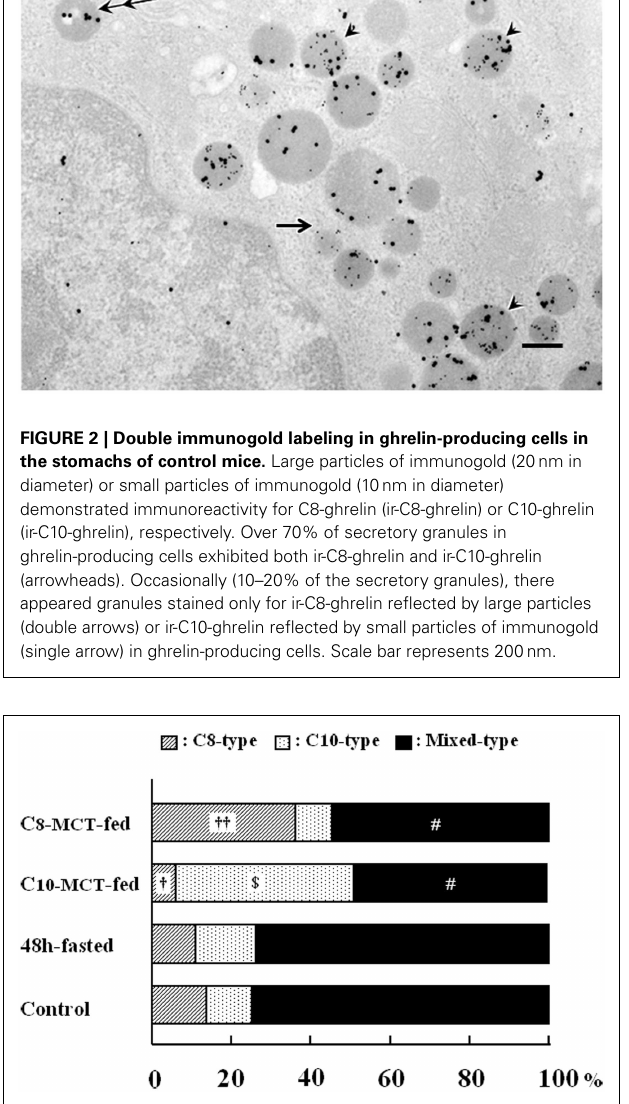
granules in ghrelin-producing cells under different